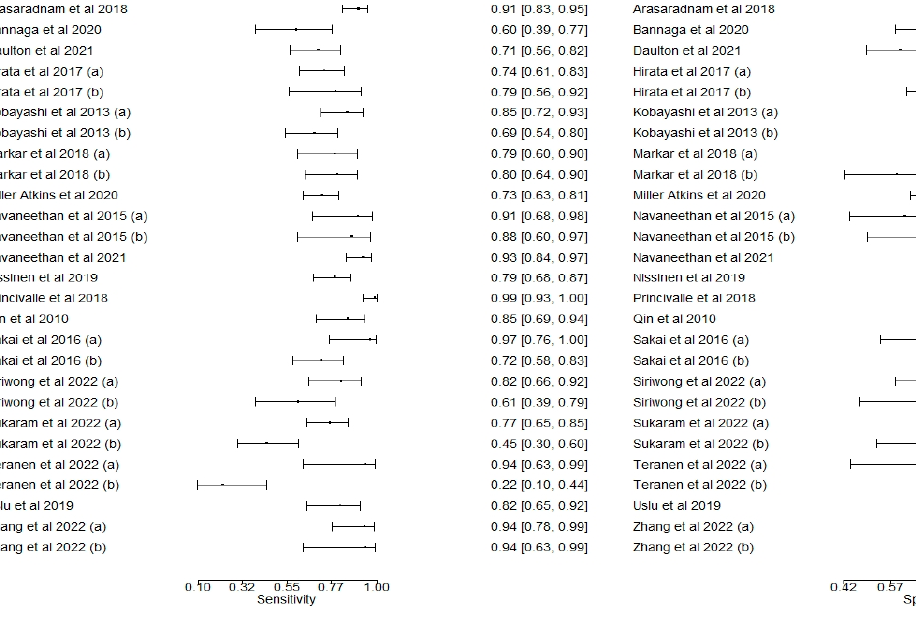
Figure 2. Forest plot illustrating the performance of volatile organic compounds for the detection of hepatobiliary and pancreatic cancer.